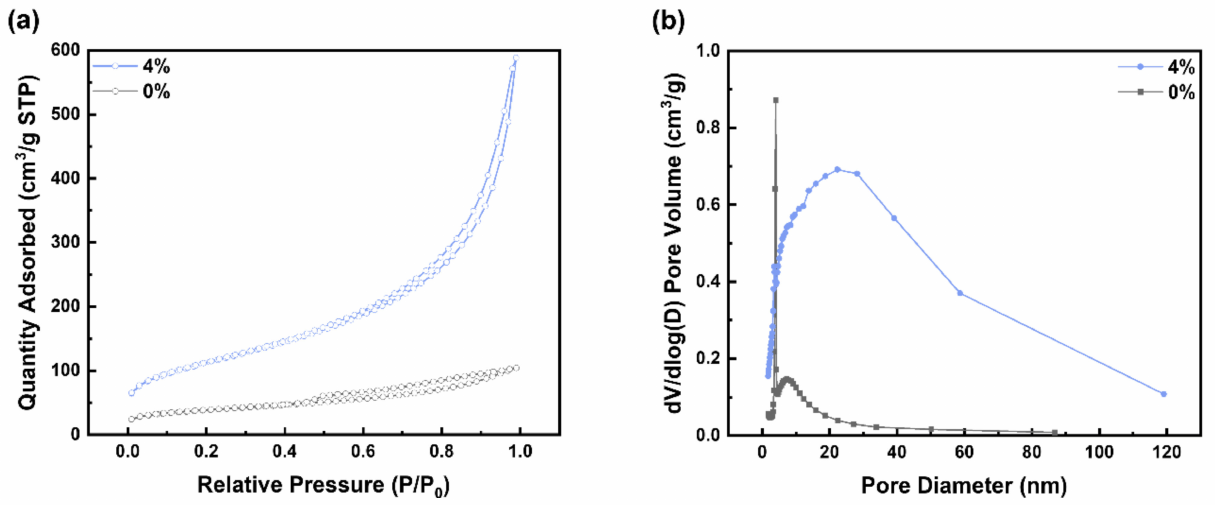
Figure 7. ( a ) N 2 adsorption–desorption isotherms, and ( b ) BJH pore size distribution curve of AS-0 and